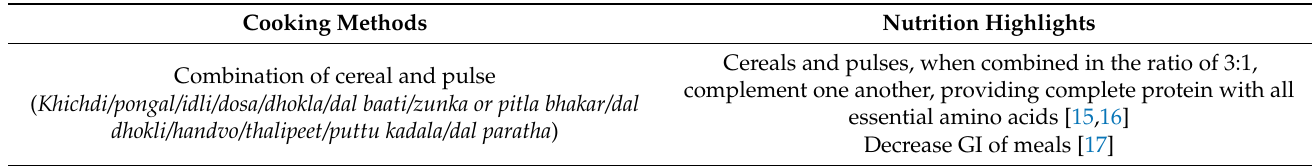
Table 1. Methods and techniques used in Indian cooking and its nutritional